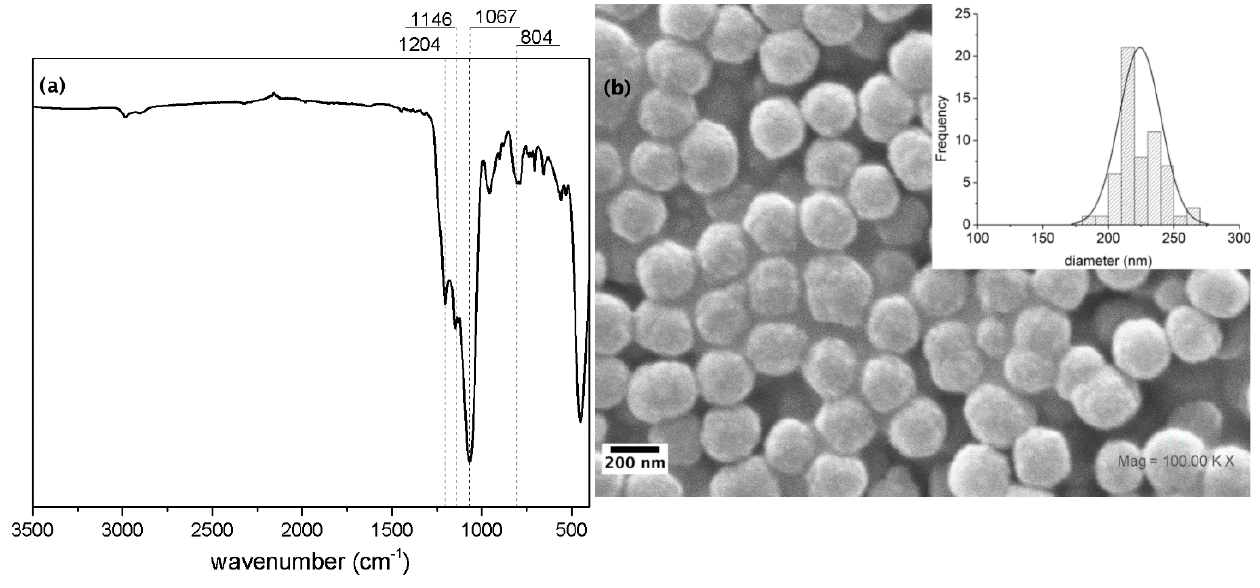
Figure 1. ( a ) ATR-FTIR and ( b ) representative SEM micrograph of SiO 2 NPs@CF, with (inset) the corresponding histogram.